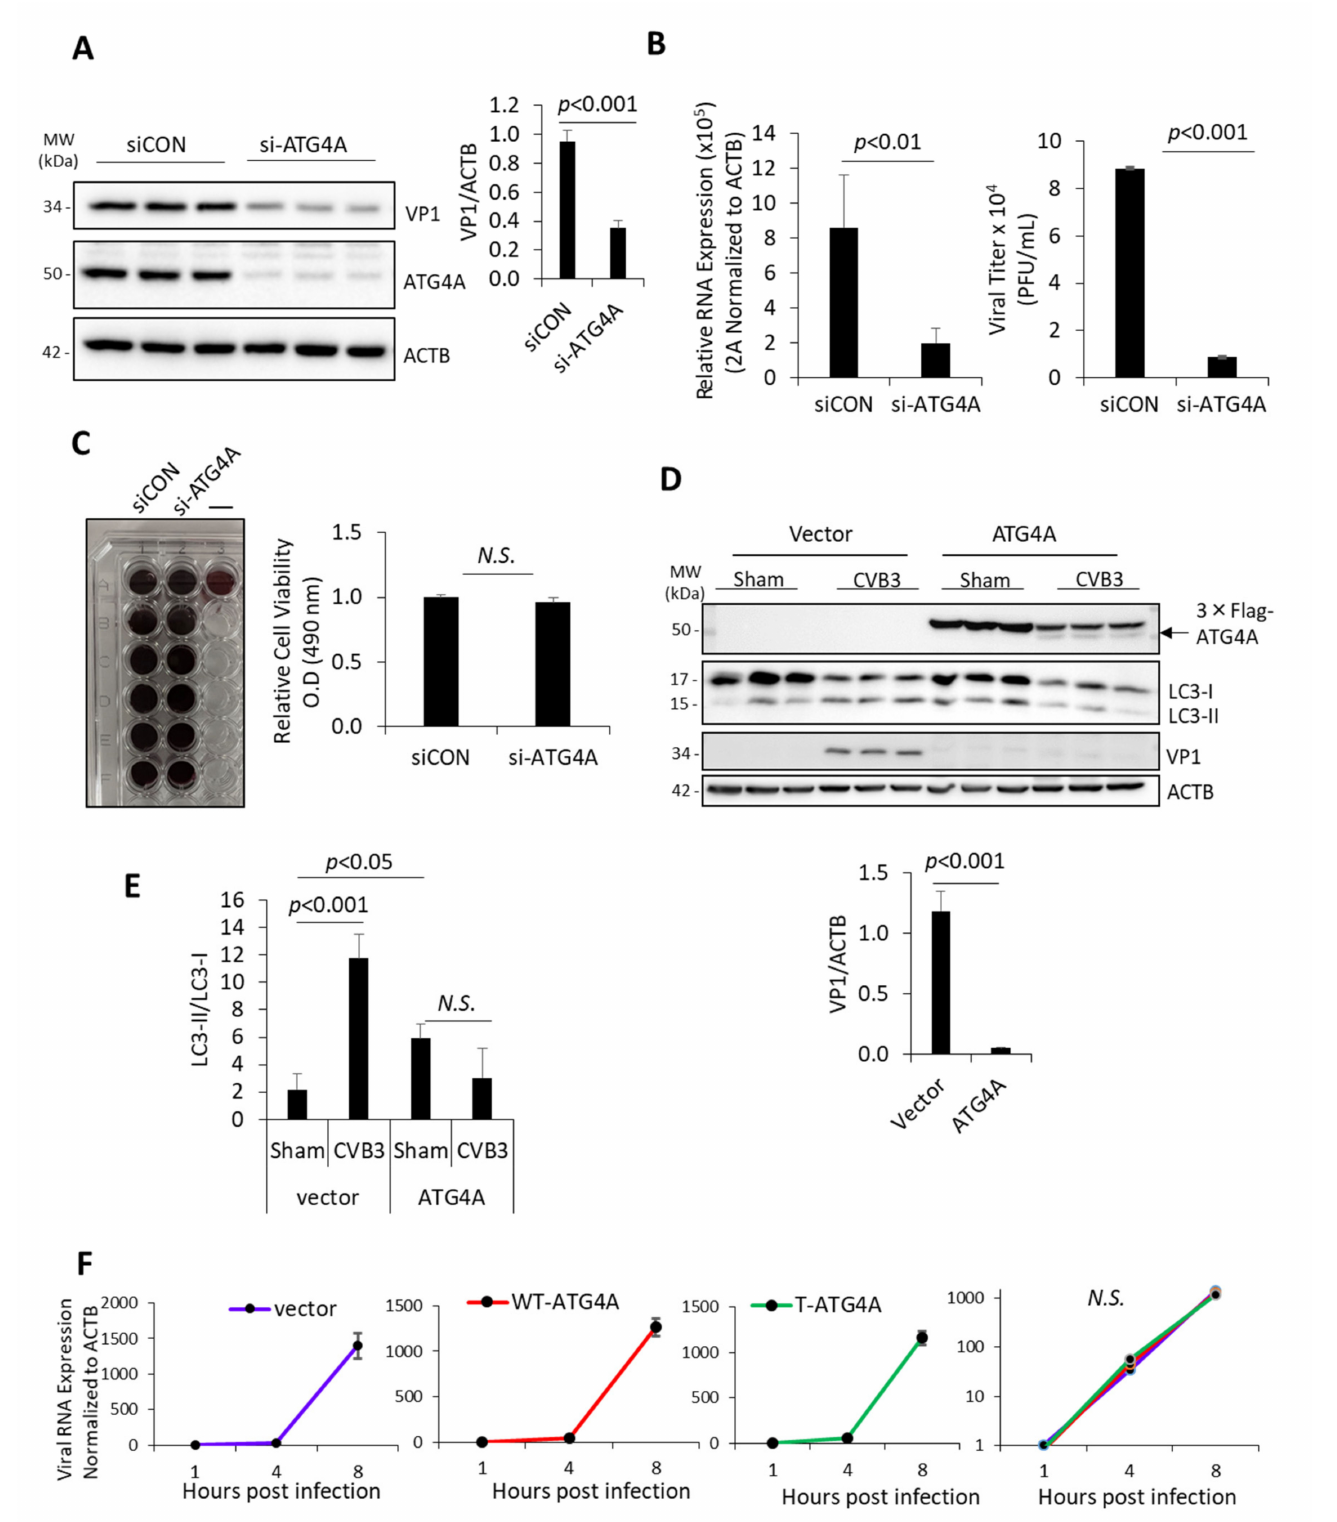
Figure 3. Endogenous Concentration of ATG4A has pro-viral function. ( A , B ) HeLa cells were transfected with control siRNA (siCON) or siRNA specifically targeting ATG4A for 48 h, followed by CVB3 (MOI = 10) or sham infection for 8 h. Western blot was conducted to analyze VP1 expression and verify knockdown efficacy of ATG4A (A, left). Level of VP1 was quantified by densitometry